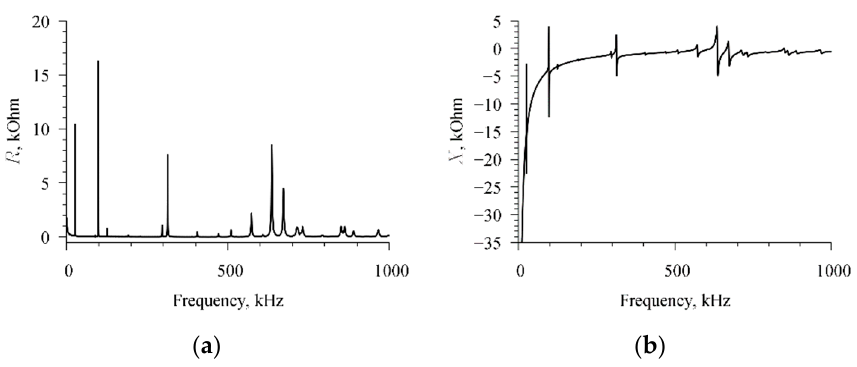
Figure 3. Results of measuring the frequency dependence of the electrical impedance of the resonator. ( a ) The real part of the electrical impedance and ( b ) the imaginary part of the electrical